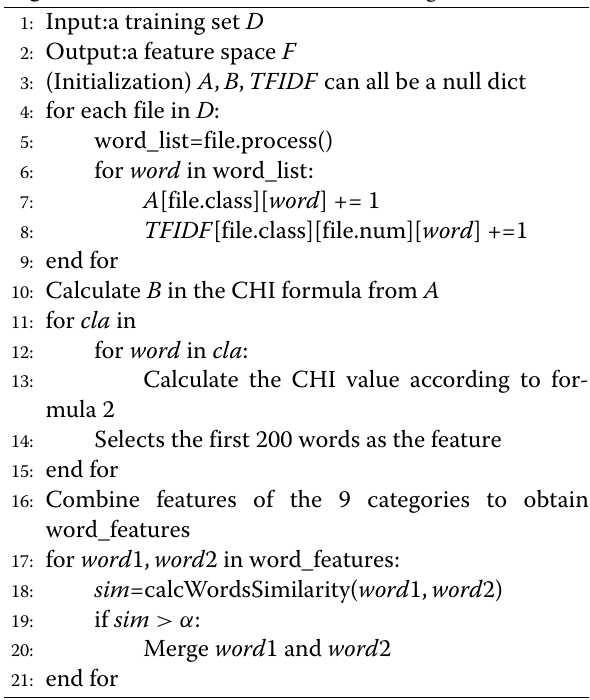
Algorithm 1 SM-CHI feature selection algorithm